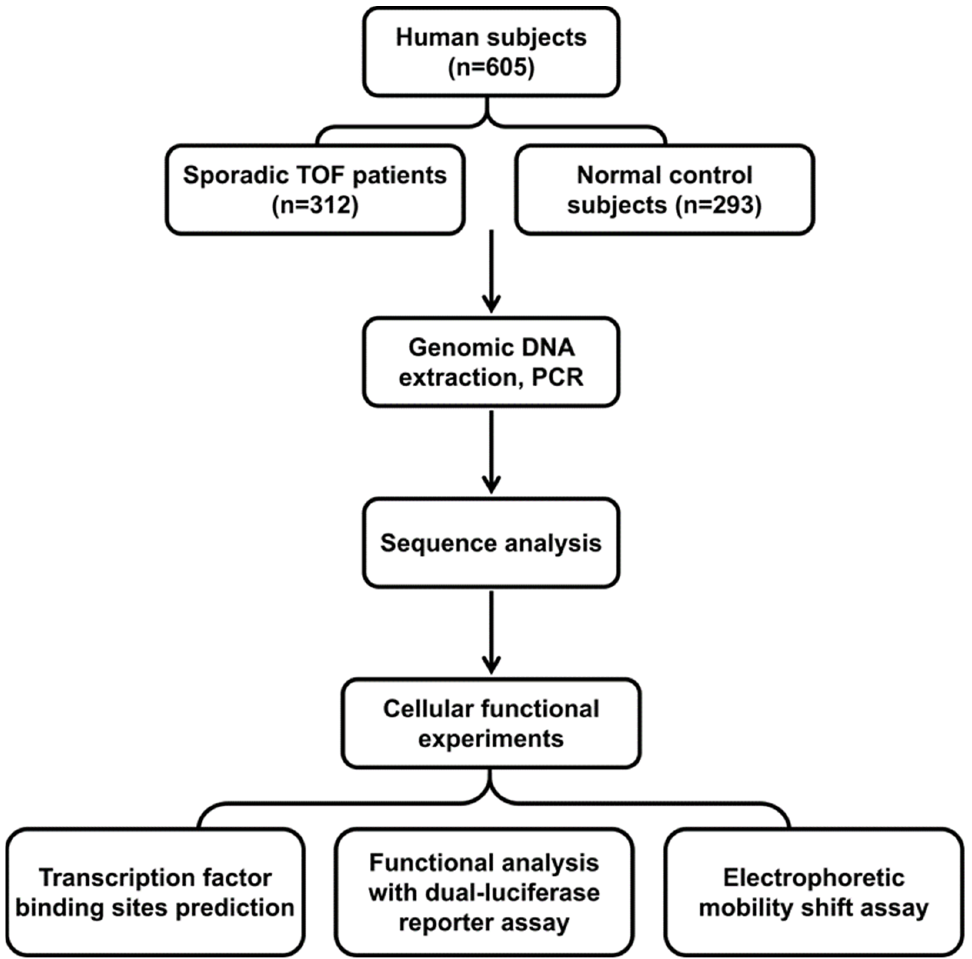
Figure 1. Study flow chart and experimental procedures. A total of 605 subjects participated in the study, including 312 tetralogy of Fallot (TOF) patients. Sequence analysis, cell function experiments, electrophoretic mobility shift analysis, and bioinformatics analysis were performed. Table 1. Primers used in this